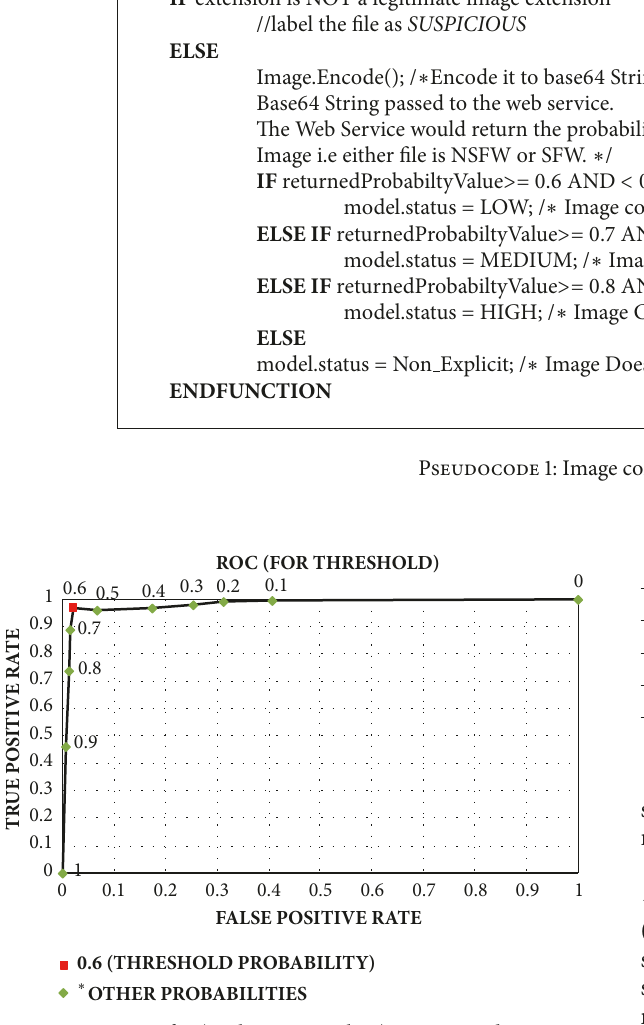
from 0.1 to 1 with an interval of 0.1 and a Receiver Operating Characteristic (ROC) Curve as shown in Figure 5 is obtained that shows the preeminent threshold value to differentiate between explicit and nonexplicit images.